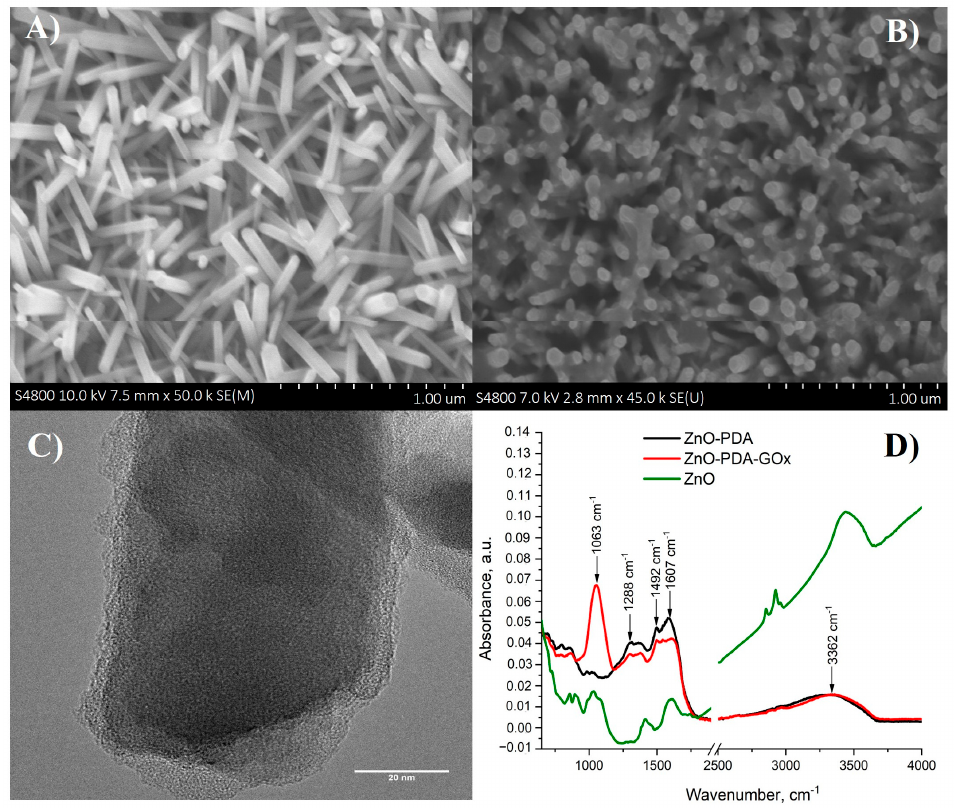
Figure 1. ( A ) SEM image of formed ZnO-NRs; ( B ) SEM image of ZnO-PDA nanocomposite structure; ( C ) TEM image of ZnO-PDA nanocomposite structure, and ( D ) FTIR spectra of ZnO and ZnO-PDA nanocomposite structure before and after GOx immobilization.